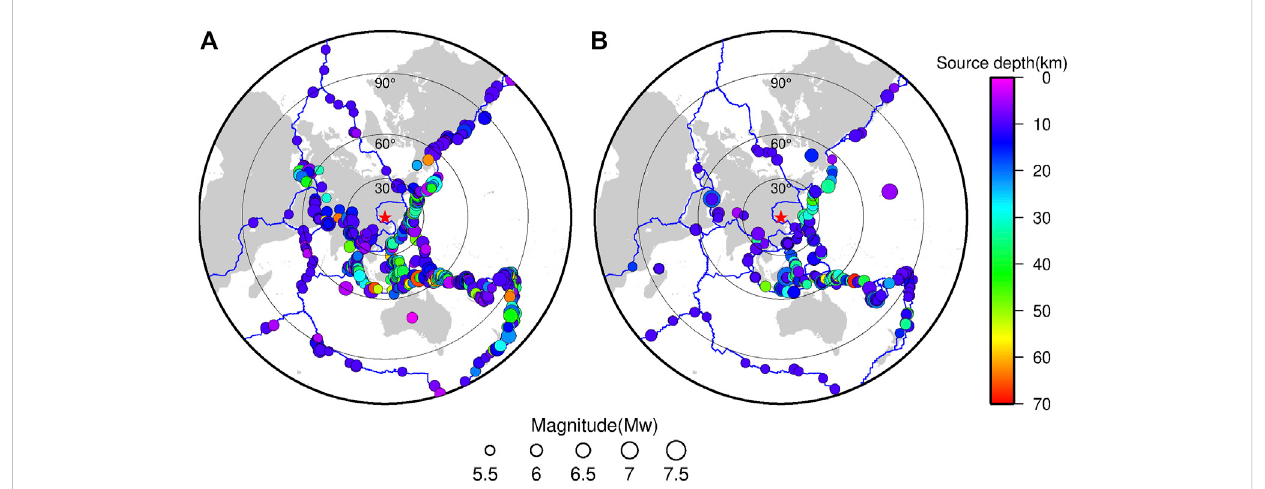
FIGURE 2 Distribution ofEventsof (A) NMarrayand (B) ABarray.Theredpentagramcorrespondstothecenterofstudyarea,andthecirclesof30 ° ,60 ° and90 ° represent the epicentral distance between the earthquake epicenter and the station are 30 ° , 60 ° and 90 ° respectively. The blue lines represent the plate boundaries.